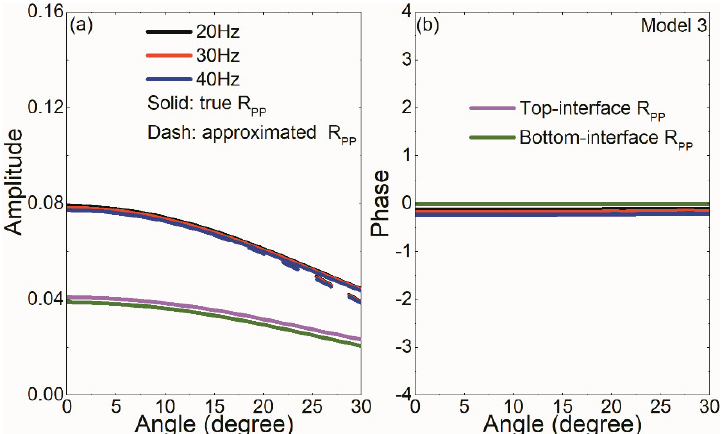
Figure 6. Comparison of Model 3’s R PP calculated by true value and the second-order series approximation, and top-interface and bottom-interface R PP calculated by the Zoeppritz equations, ( a ) amplitude, and ( b ) phase.